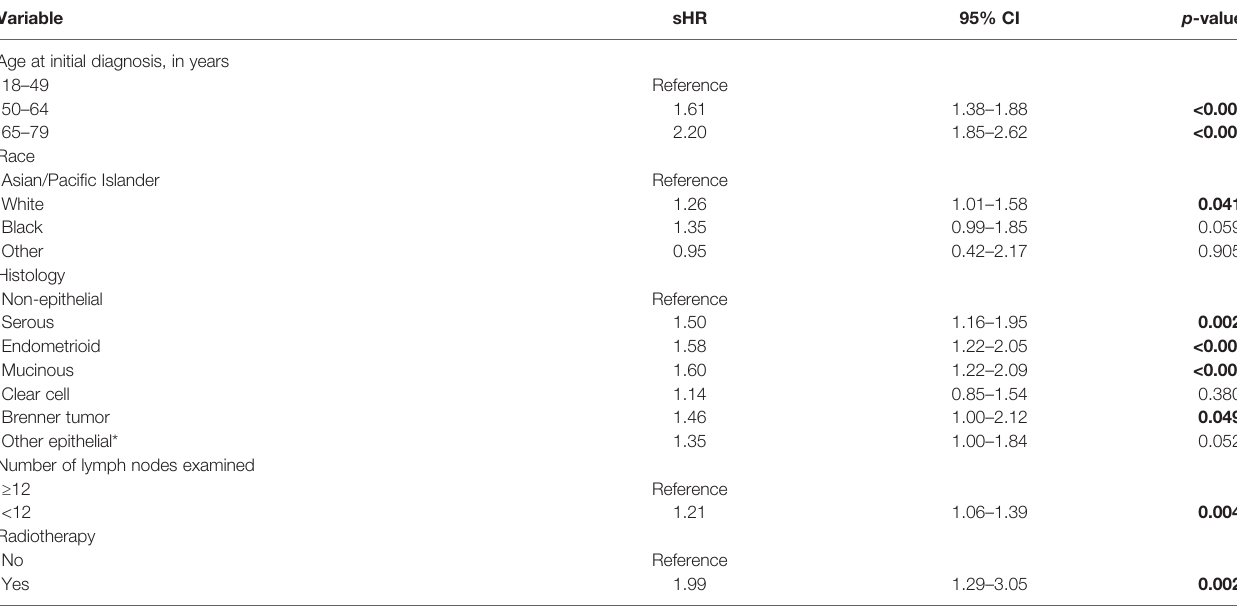
TABLE 2 | Signi fi cant factors associated with second primary malignancies included in the fi nal Fine and Gray subdistribution hazards model.